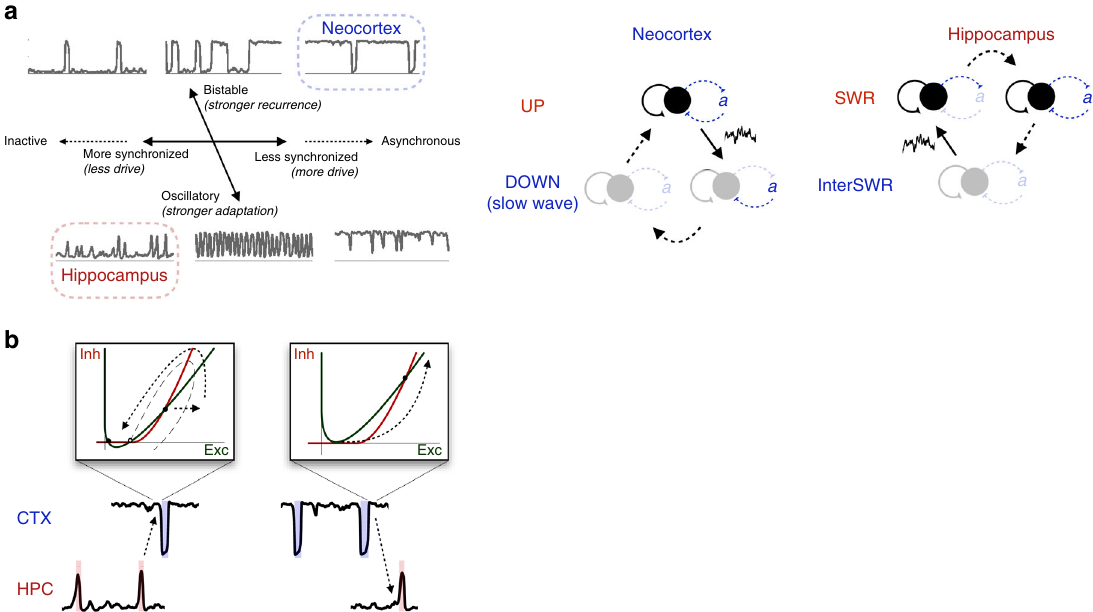
Fig. 7 Excitable dynamics of NREM sleep. a UP/DOWN alternation dynamics are characterized by a spectrum of two effective axes: a degree of synchronization axis determined by the level of drive in the system, and an oscillatory-bistable axis determined by the relative strength of recurrence and adaptation. The tilt of the oscillatory-bistable axis re fl ects the decrease in the amount of drive needed for equi-duration UP/DOWN states ( I 1/2 ) as recurrence is increased or adaptation is decreased. (Right) Schematic of the neocortical and hippocampal excitable regimes that produce slow waves and SWRs. Solid arrows indicate noise-induced transitions. b Hypothesis for mechanism of SWR/slow wave coupling by excitable